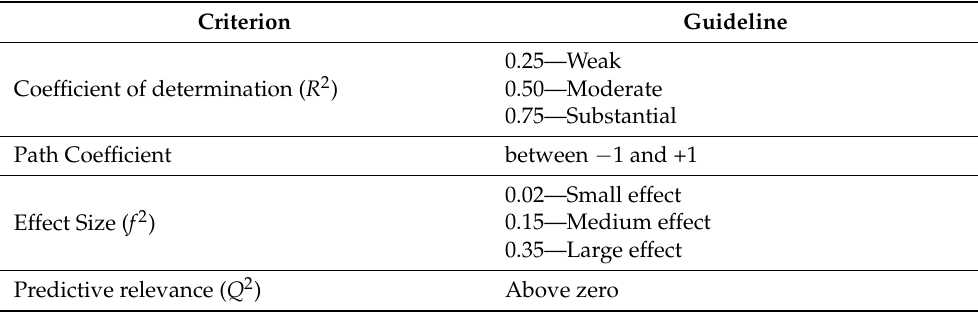
Table 14. Assessment of the structural